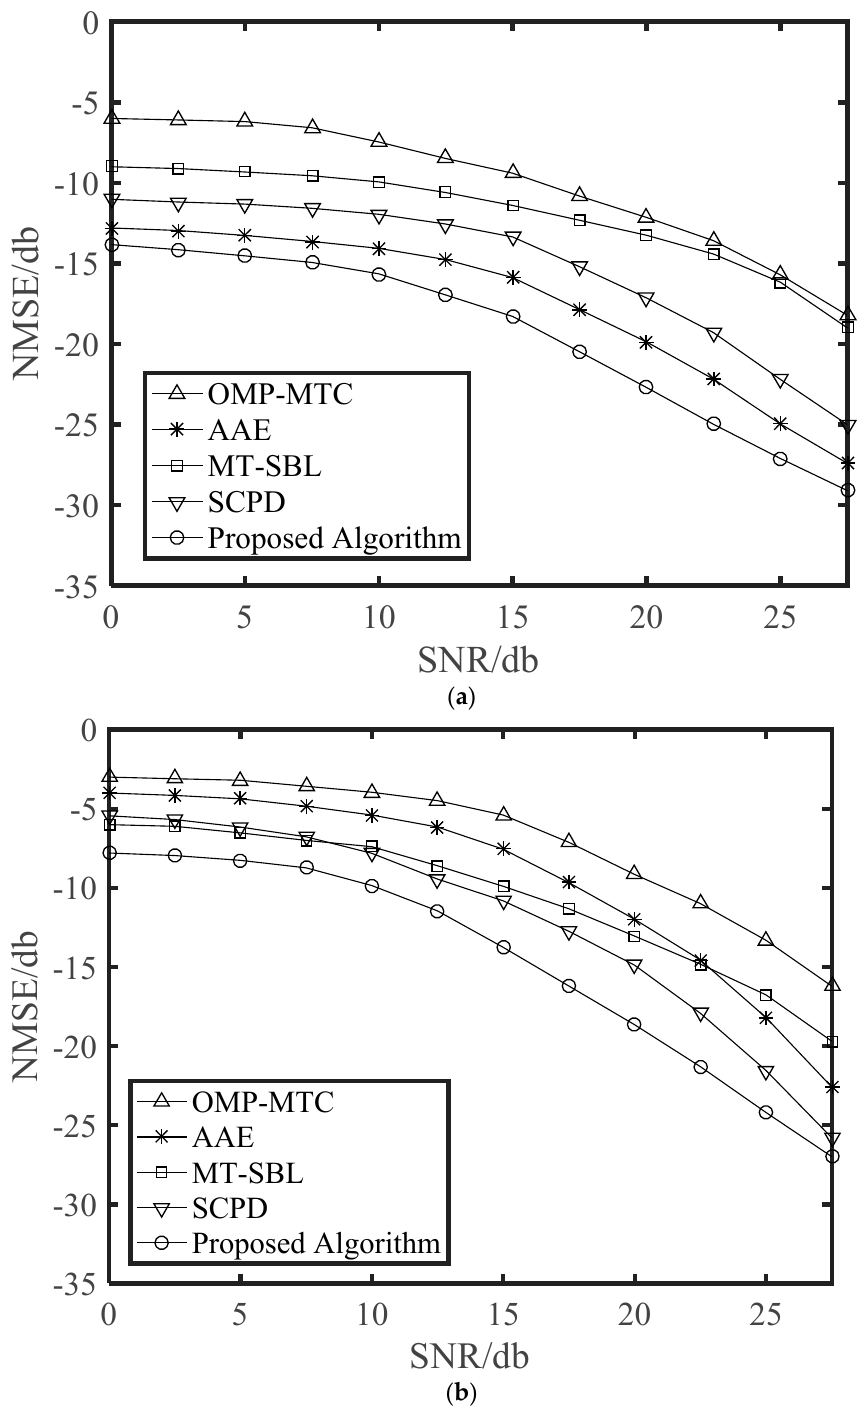
Figure 2. NMSE performance against SNR with a single vehicle, G T = 128, G R = 32, N R = 16, and N T = 64 antennas. ( a ) v = 120km/h. ( b ) v = 200km/h.